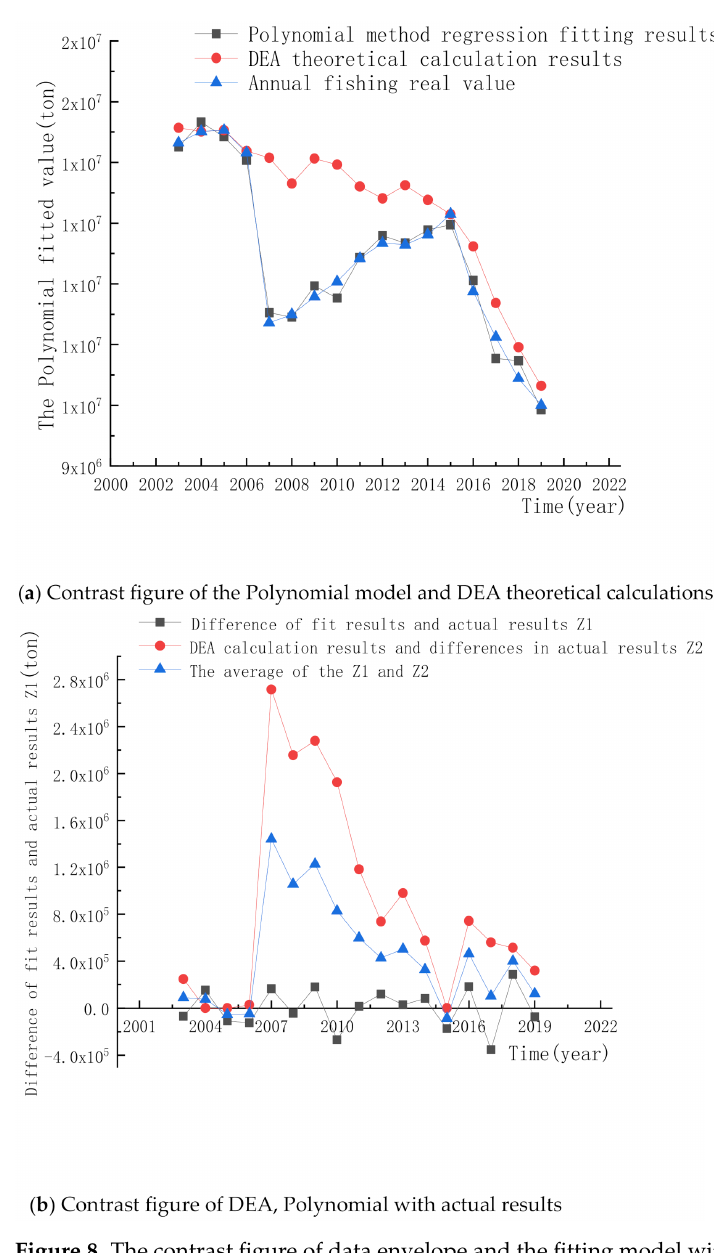
Figure 8. The contrast figure of data envelope and the fitting model with actual